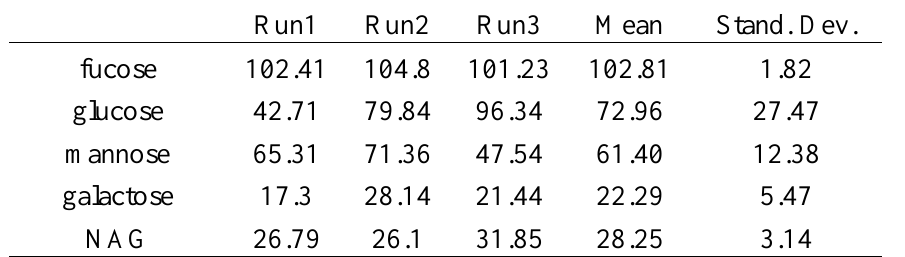
Table 2. Measured angle (degrees) between the least squares plane through the pyranose ring of the ligands and the plane of the Trp243 side indole of CRD.